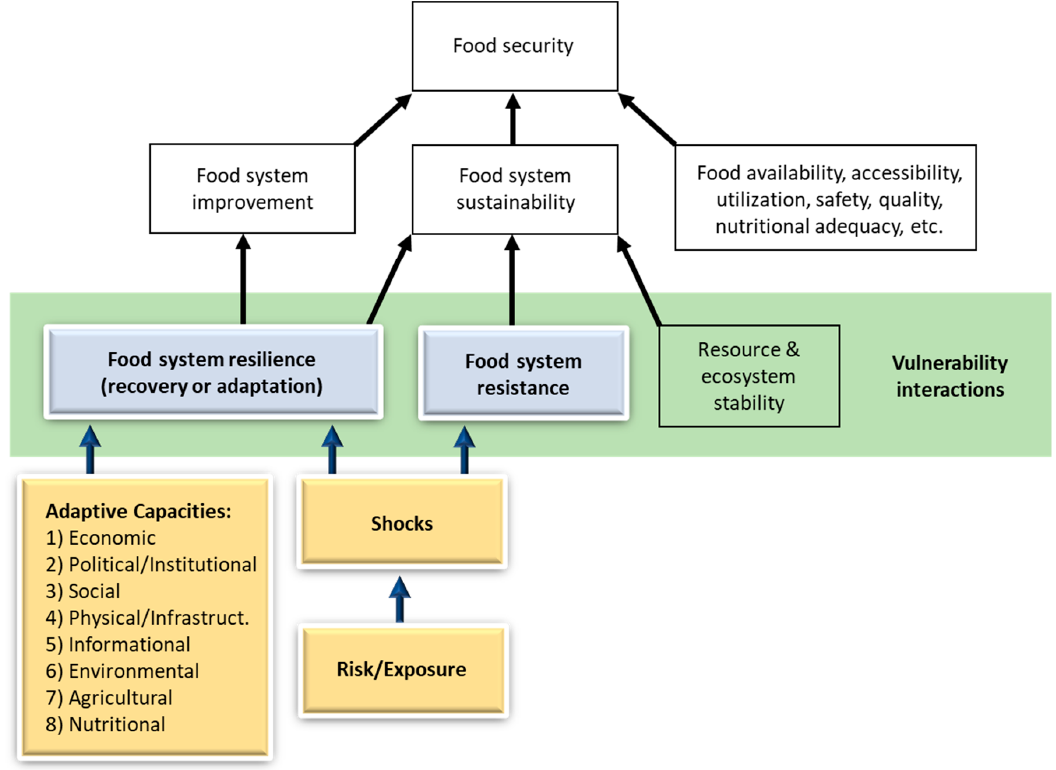
Figure 1. The figure shows relationships among key concepts and food system resilience. Arrows indicate that concepts contribute to or influence other concepts in the diagram. Table 1. Definitions for Figure 1 illustration.